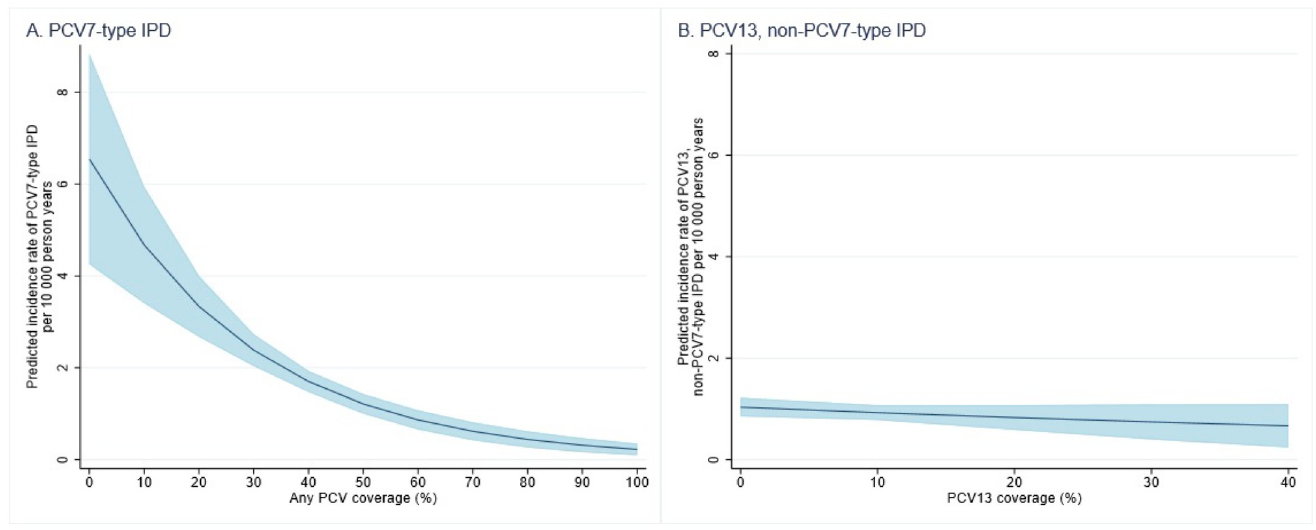
Fig 4. Estimated rate of VT IPD incidence � and 95% CIs (blue shading) among undervaccinated children under 5 years, at each decile of PCV coverage, New South Wales and Western Australia, 2001–2012. � PCV13, non-PCV7-type IPD incidence was only estimated up to 60% as there were few data points available. CI, confidence interval; IPD, invasive pneumococcal disease; PCV, pneumococcal conjugate vaccine; PCV7, 7-valent PCV; PCV13, 13-valent PCV; VT,